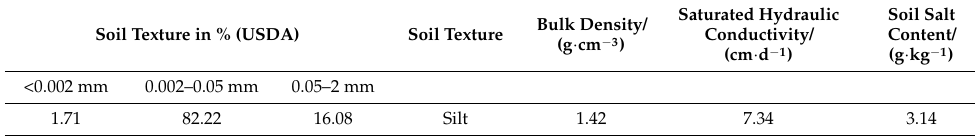
Table 1. Physical and chemical characteristics of the soil filled in the simulation boxes.